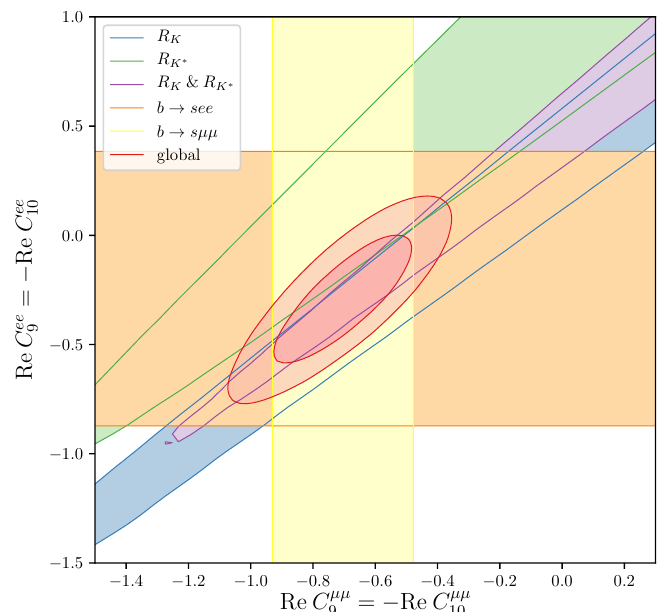
, b ! s(cid:22)(cid:22) , and b ! see K vs. C ee plane, assuming 9 ;sb 9 ;sb = (cid:0) C (cid:22)(cid:22) and C ee = (cid:0) C ee . The global (cid:12)t is obtained at the b -quark 9 ;sb 10 ;sb 9 ;sb 10 ;sb